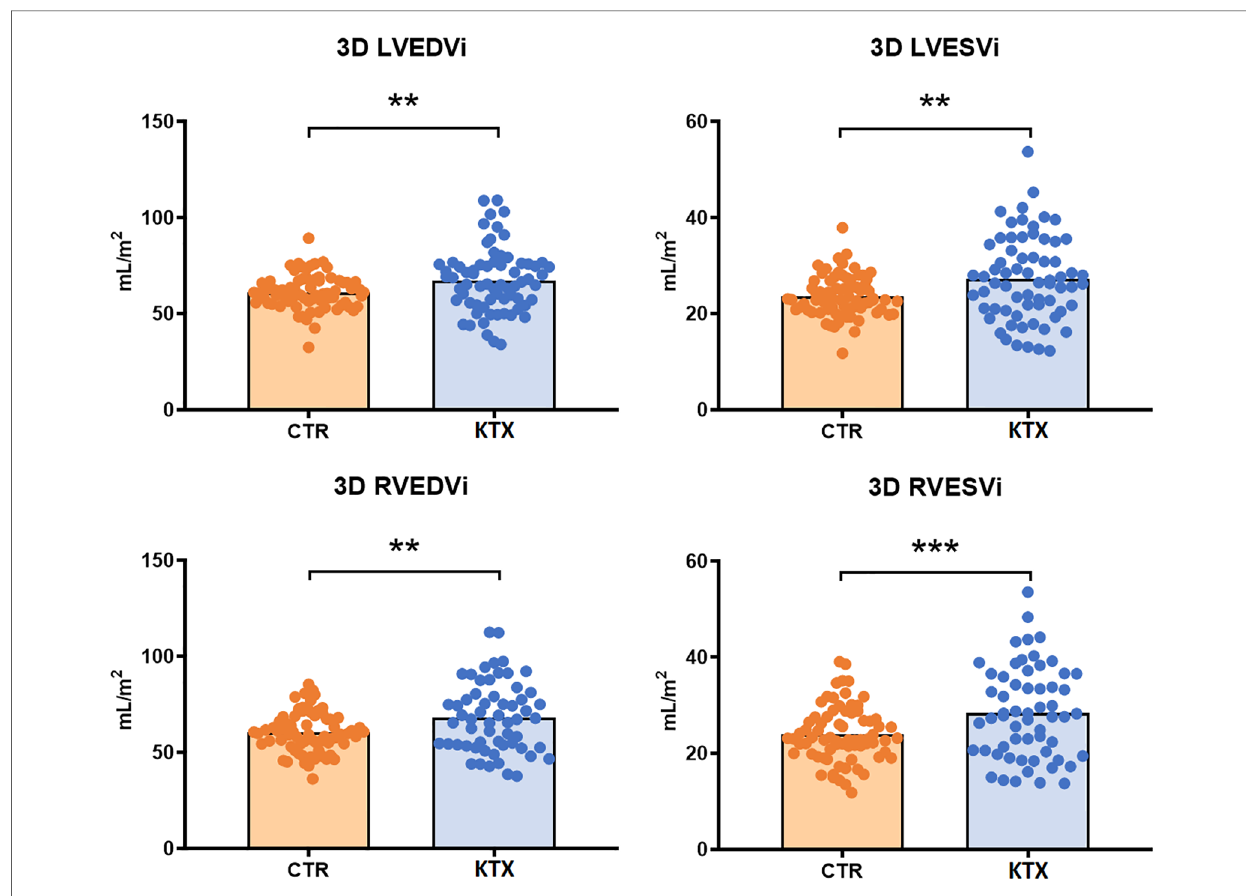
FIGURE 1 3D ventricular morphological measures of the two study groups. LVEDVi, LVESVi, RVEDVi and RVESVi were all signi fi cantly increased in the transplant group. LVEDVi, left ventricular end-diastolic volume index; LVESVi, left ventricular end-systolic volume index; RVEDVi, right ventricular end- diastolic volume index; RVESVi, right ventricular end-systolic volume index; CTR, control group; KTX, kidney transplant group; *= p <0.05; **= p <0.01; ***= p